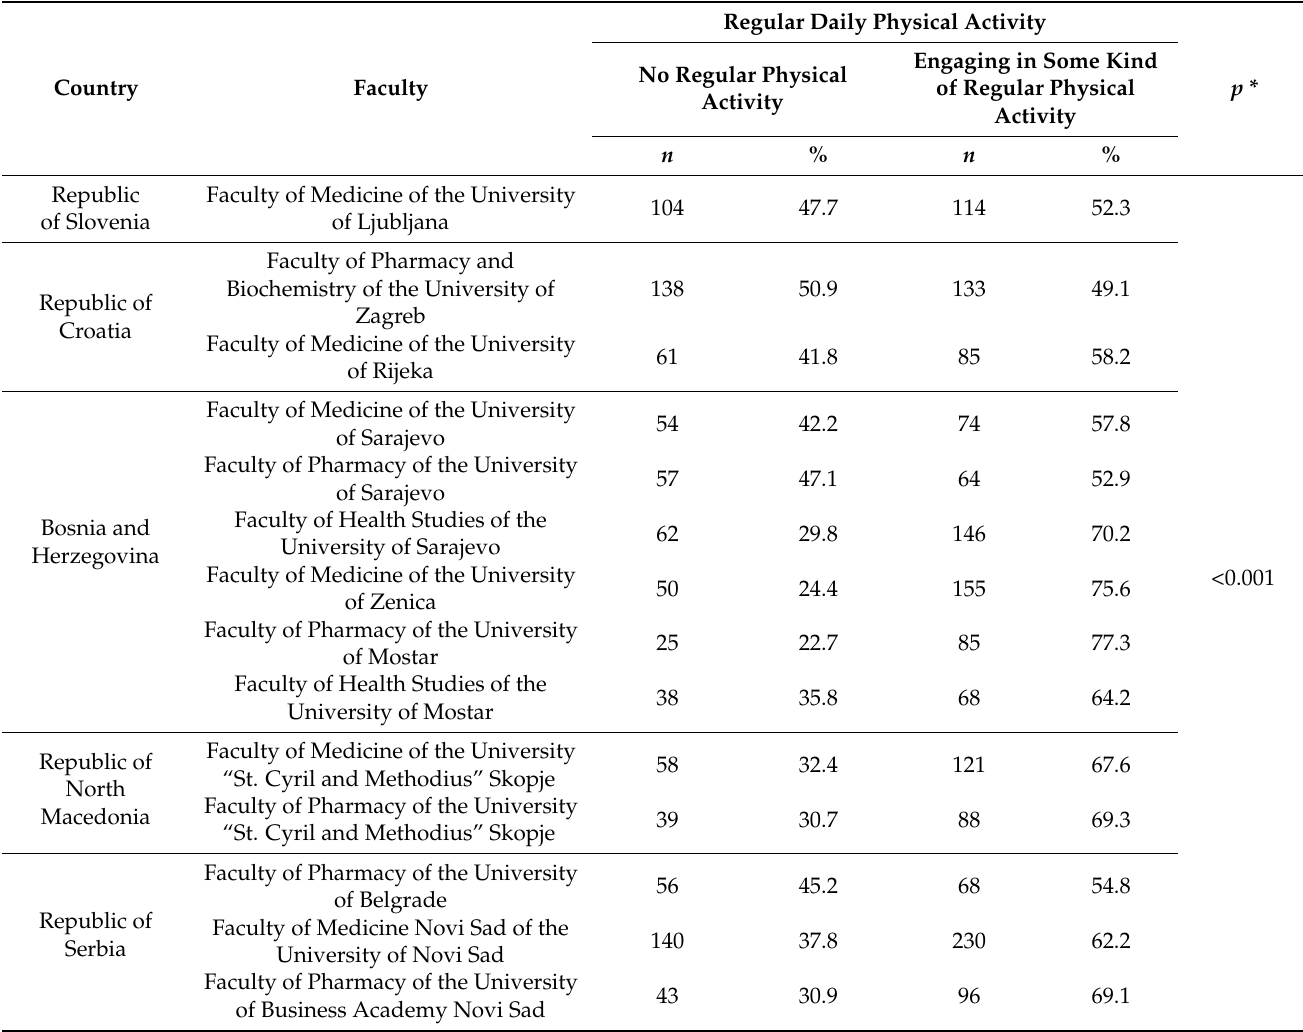
Table 2. Distribution of the medical students ( n = 2452), according to regular daily physical activity, in relation to the attended